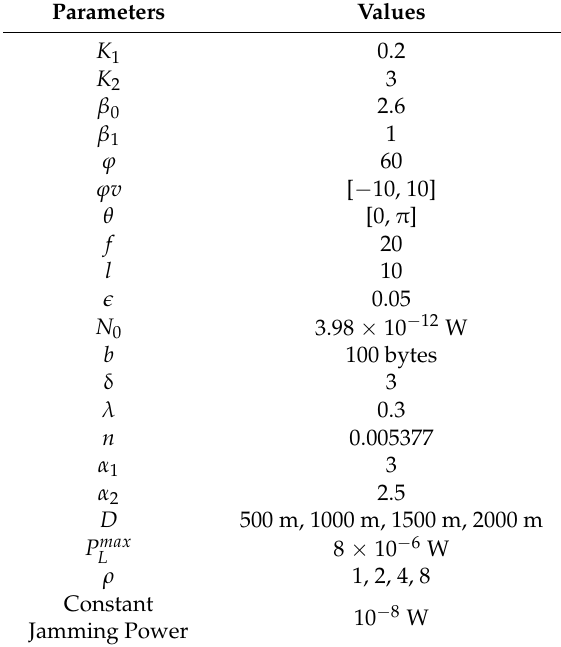
Table 2. Simulation